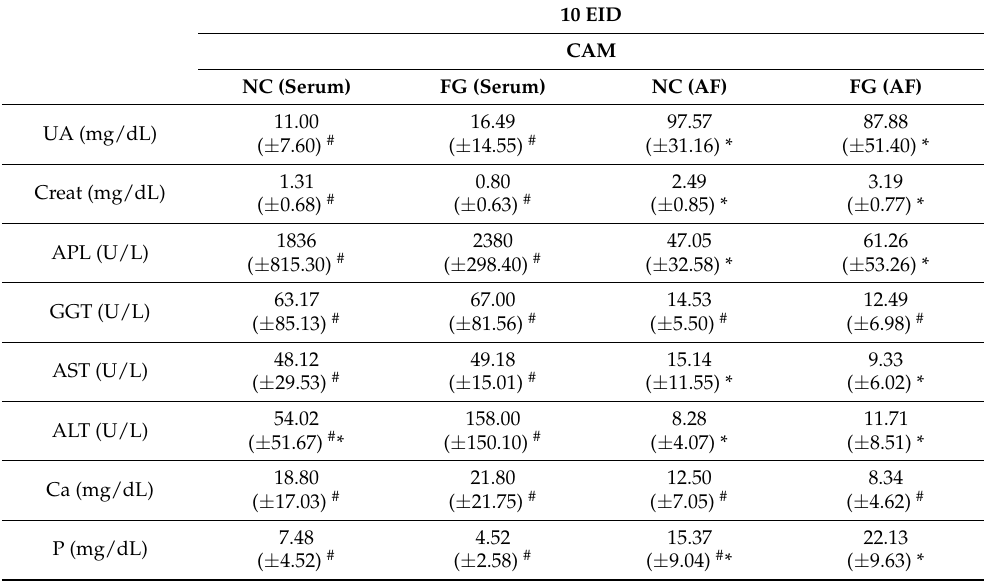
Table 7. Quantification of metabolites, minerals and enzymes in serum and AF in CE treated with FG and DX at 10EID inoculated via CAM.